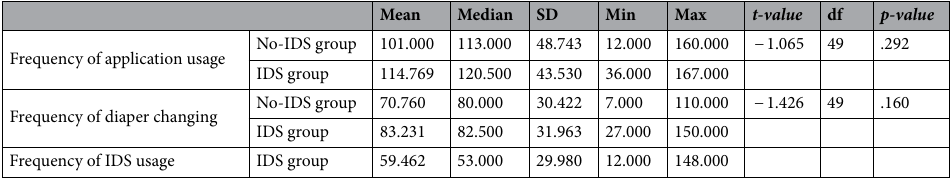
Table 3. Summary statistics on frequency of application usage and IDS